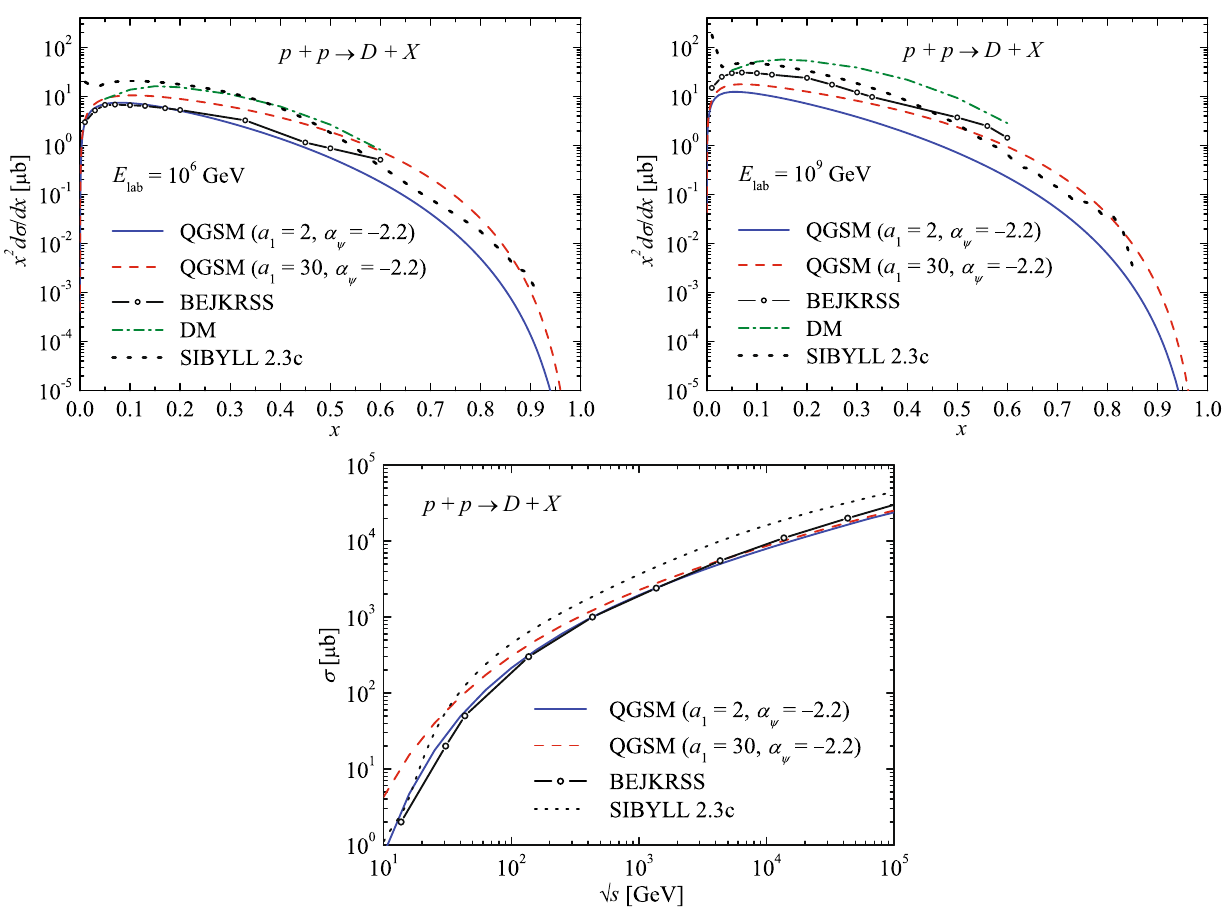
Fig. 12 Model predictions for the differential (top) and total (bottom) cross sections of D / ¯ D mesons production in pp collisions: QGSM with α ψ ( 0 ) = − 2 . 2 for a 1 = 2 (solid line) and a 1 = 30 (dash), NLO